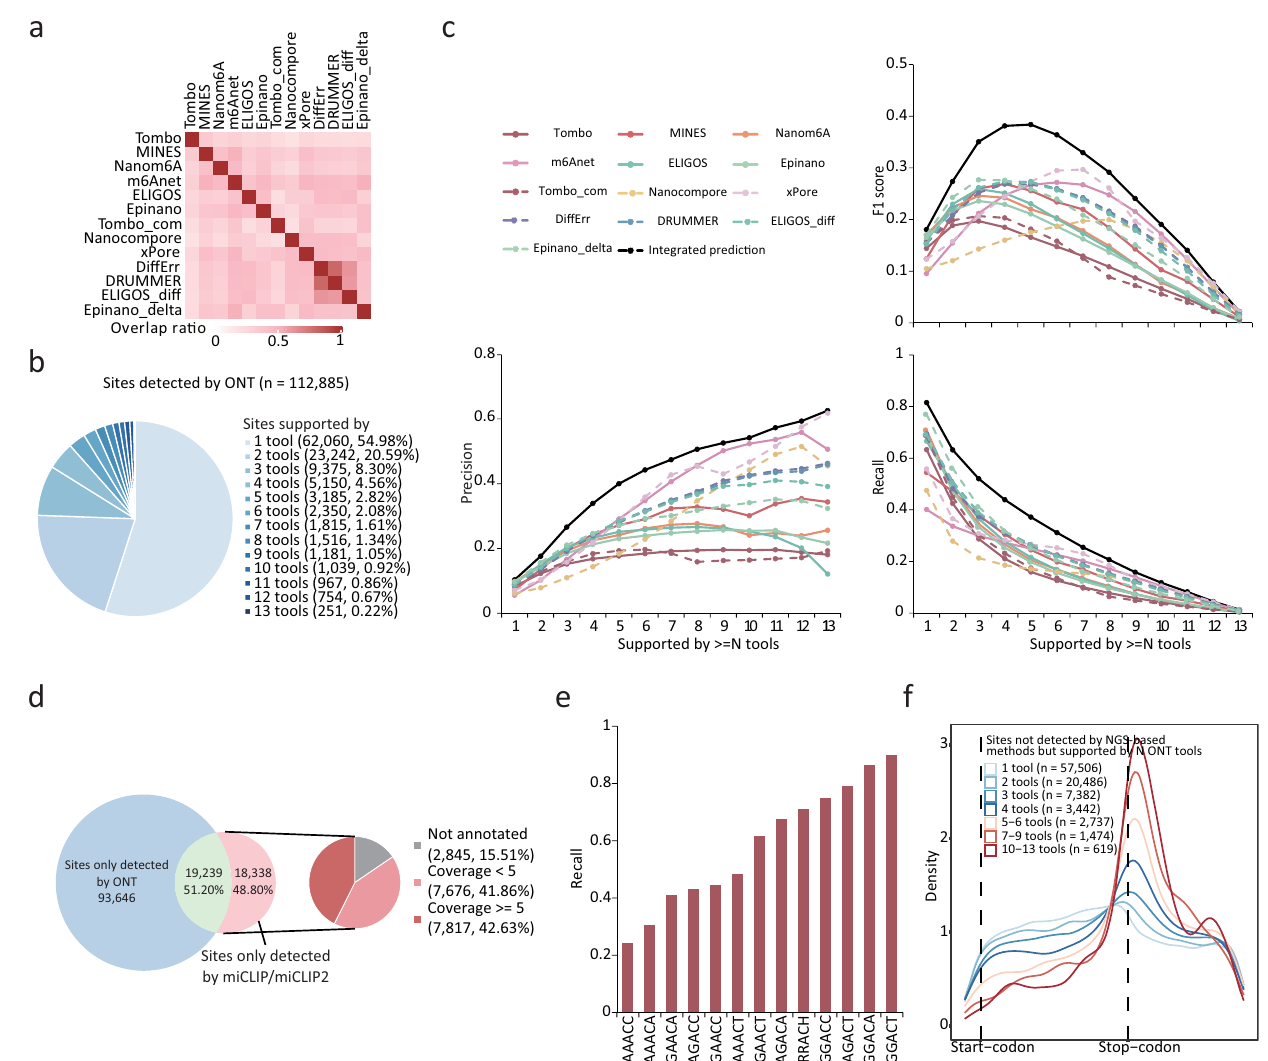
Fig. 7 | Assessment of m6A detection by integrating results from all tools. a Recurrentsitesratioamongtop5000m6AsitesdetectedbyONTtools.Heatmap shows the percentage of sites simultaneously detected by each pair of tools. b Percentage of sites identi fi ed by multiple tools. c Precision, recall rate and F1 scores of sites supported by more than N tools versus identical number of top sites from individual tool. The validation set was derived from the miCLIP results. d Merged sites detected across all toolsand percentage of these sites found in the